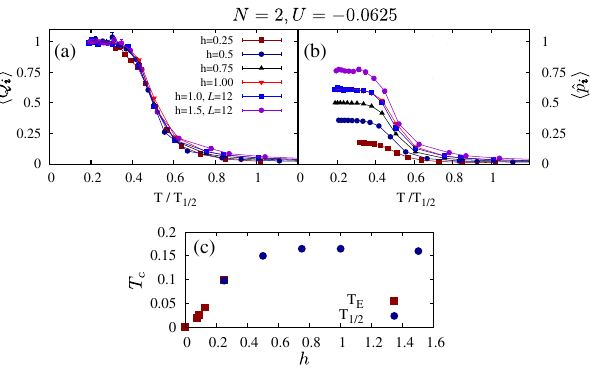
ˆ Q FIG. 9. (a) Average value of h i i in the presence of a small symmetry-breaking field, U ¼ − 0 . 0625 . (b) Average value of h ˆ p i i at the same value of the symmetry-breaking field. Unless